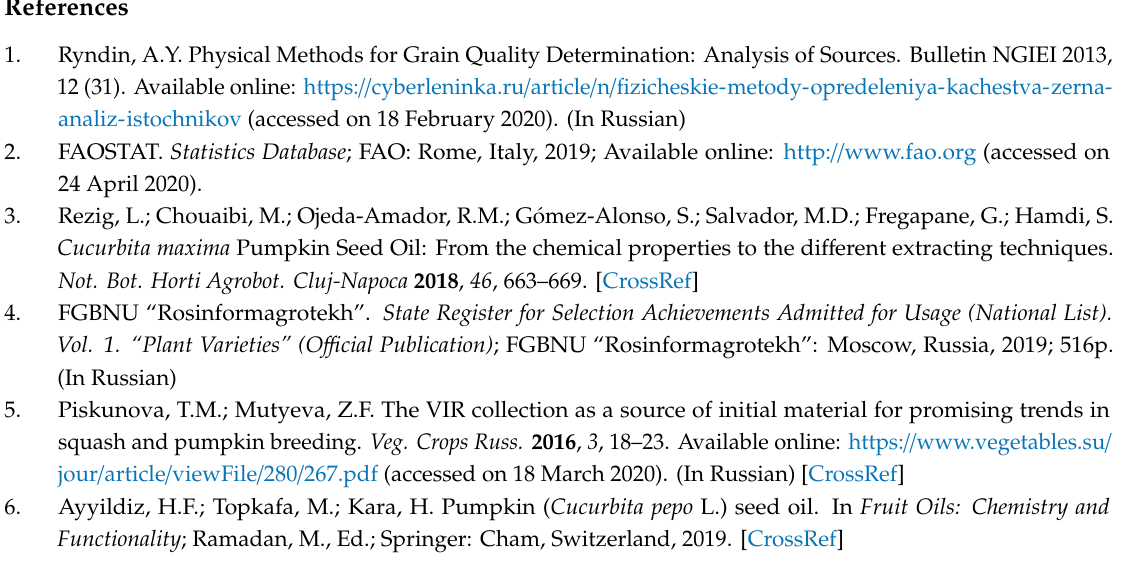
Table S1: List of accessions of Cucurbita L. species from the VIR collection used as a research material; Table S2: The monthly average of temperature ( ◦ C) and precipitation (mm) for the AOS VIR in 2015-2016; Table S3: Fatty acid profile (% of total identified FA), oil and hull content (% of dry weight) in the studied Cucurbita L. accessions from VIR collection, mean values ± SD; Table S4: Results of ANOVA for parameters of studied Cucurbita L. accessions from the VIR collection; Table S5: Factor structure of variation for parameters of the studied C. pepo , C. maxima , C. moshata , C. mixta , C. pepo var. giromontia and C. pepo var. melopepo accessions from VIR collection (analysis of principal components); Table S6: Factor structure of variation for parameters of C. pepo , C. maxima , C. moshata accessions from VIR collection (analysis of principal components); Table S7: The discriminant